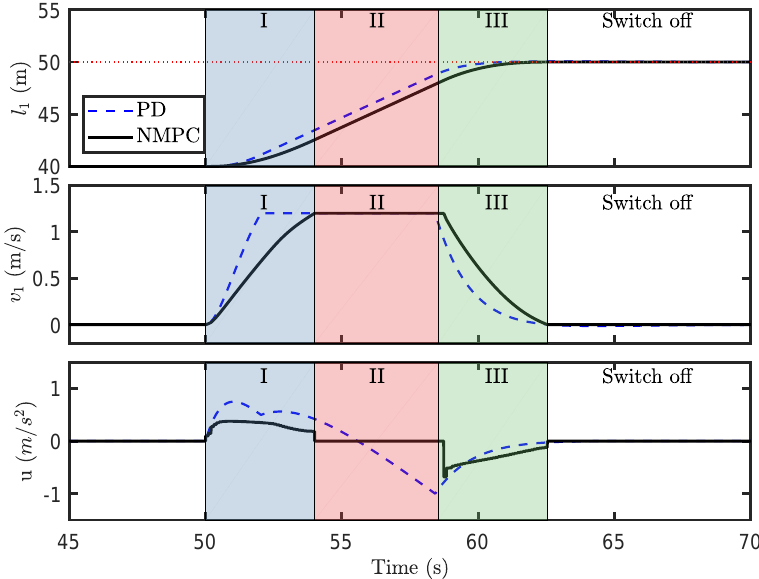
Figure 10. Performance of the PD controller with saturating elements and NMPC